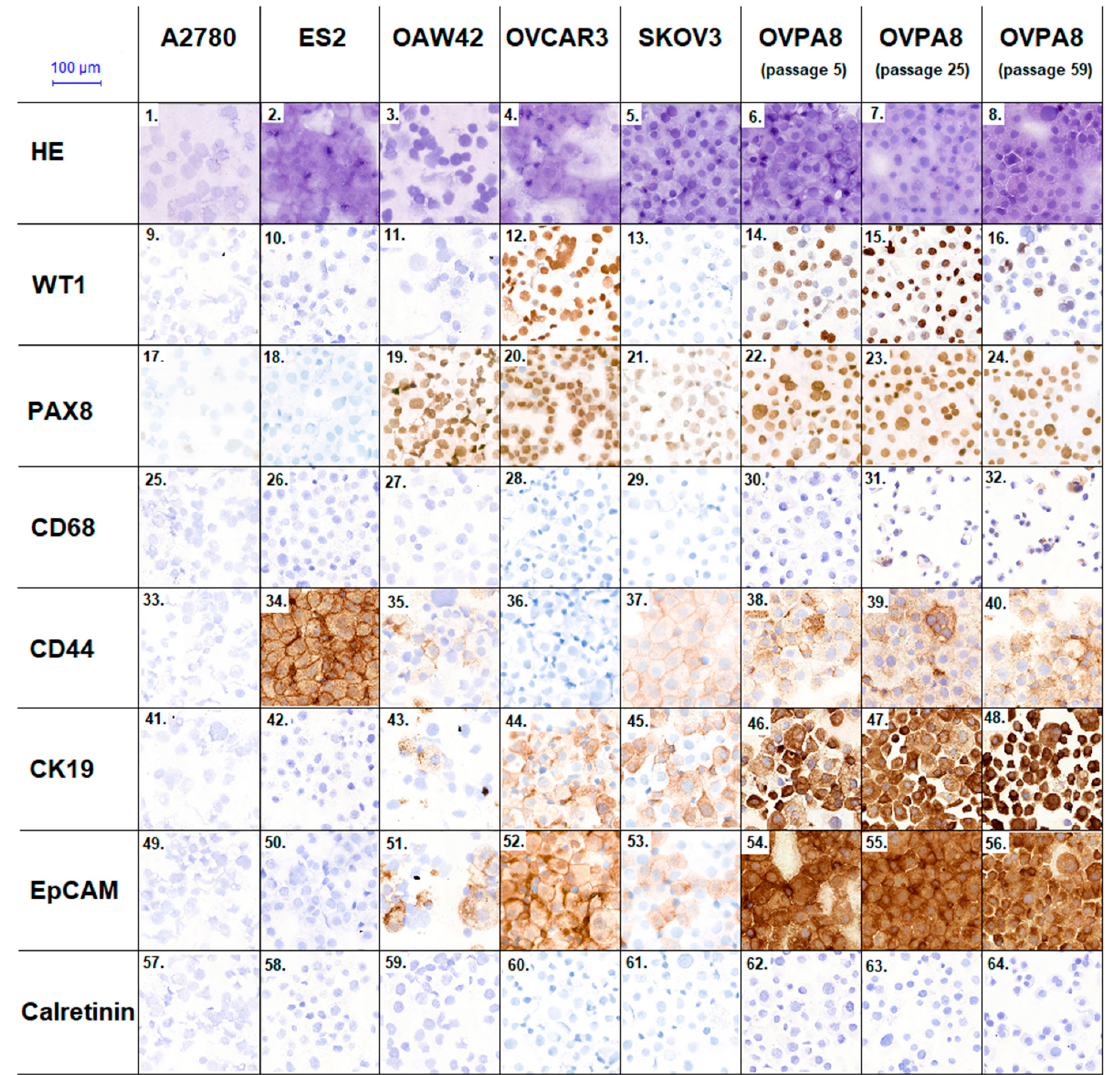
Figure 11. Immunophenotypic characterization of OVPA8 and other ovarian cancer cell lines (magnification: 200×). HE—hematoxylin-eosin staining; WT1—Wilms tumor 1 protein; PAX8—paired box 8 protein; CK19—luminal cytokeratin 19; EpCAM—epithelial cell adhesion molecule.